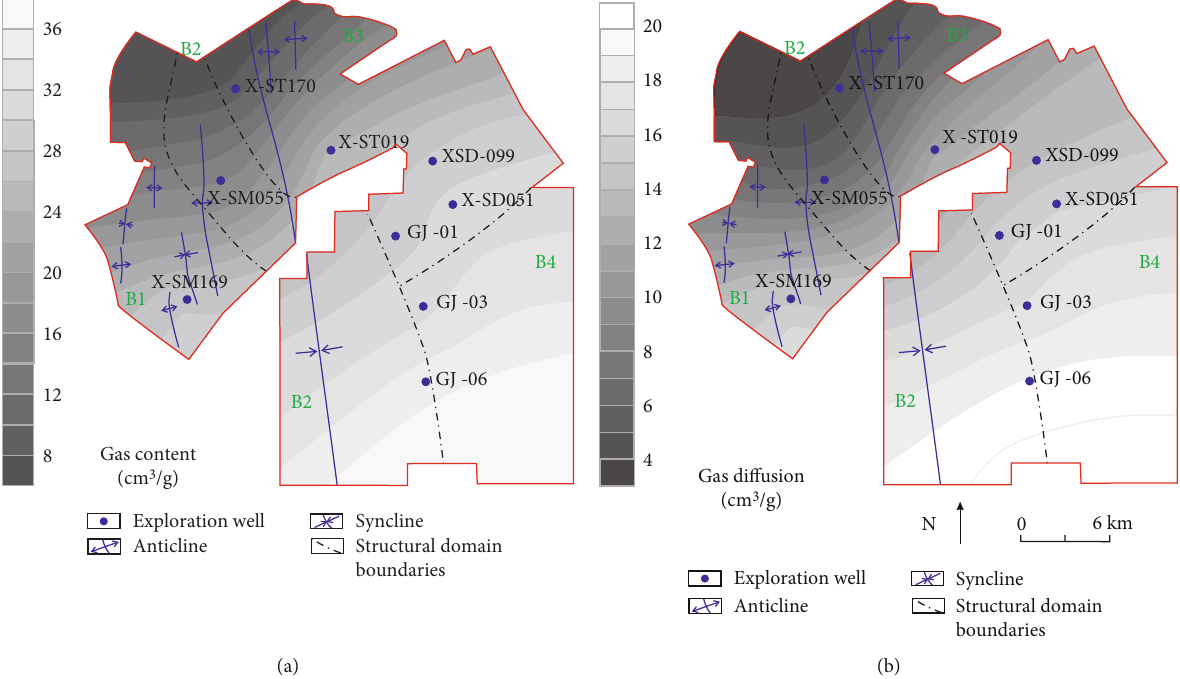
Figure 12: Distribution characteristics of gas content (a) at the end of the substage V